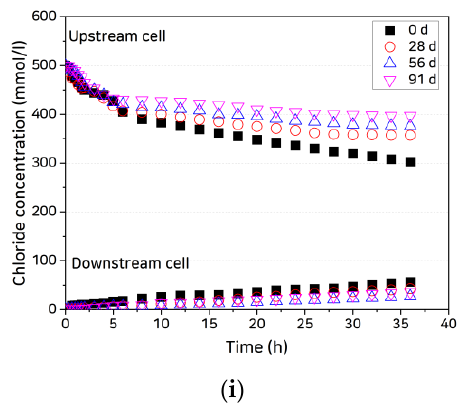
Figure 4. Variation in chloride concentrations in upstream and downstream cells: ( a ) OPC, uncracked; ( b ) SHC15, uncracked; ( c ) SHC30, uncracked; ( d ) OPC, crack width 0.3 mm, uncoated; ( e ) OPC, crack width 0.3 mm, coated; ( f ) SHC15, crack width 0.3 mm, uncoated; ( g ) SHC15, crack width 0.3 mm, coated; ( h ) SHC30, crack width 0.3 mm, uncoated; and ( i ) SHC30, crack width 0.3 mm, coated.